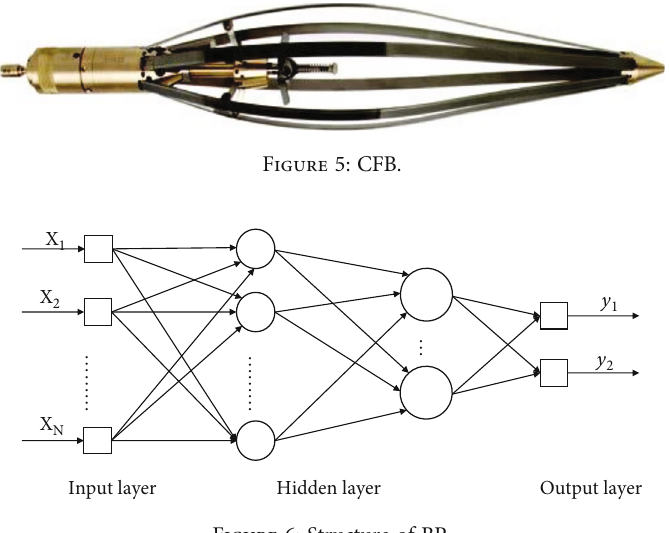
Figure 6: Structure of BP.